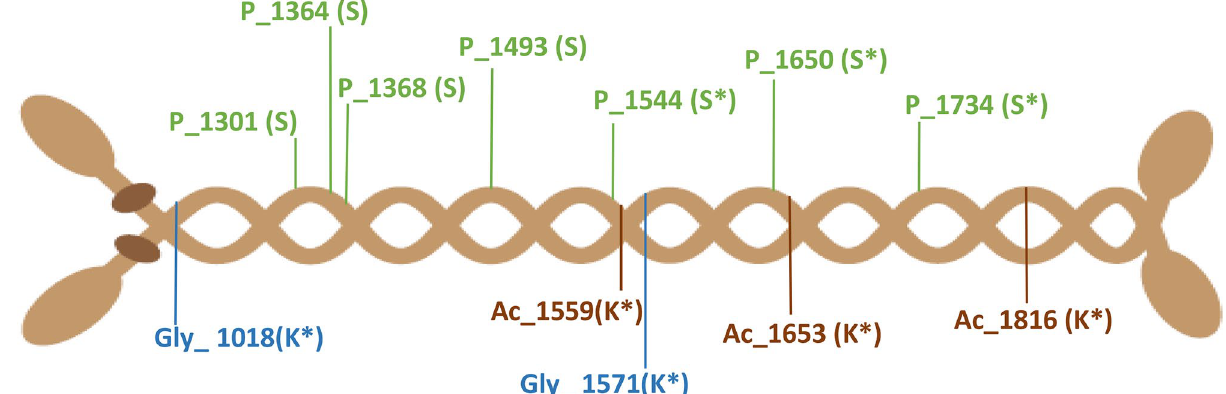
Figure 5. Cartoon representation of Myh6 and some of its PTMs. Three of the PTMs identified on Myh6 are illustrated in the cartoon: acetylation (Ac), phosphorylation (P) and glycosylation (Gly). The site and amino acid harbouring the modification is indicated. Sites with * represent novel sites. For a full list of modifications on Myh6, see Supplementary Table